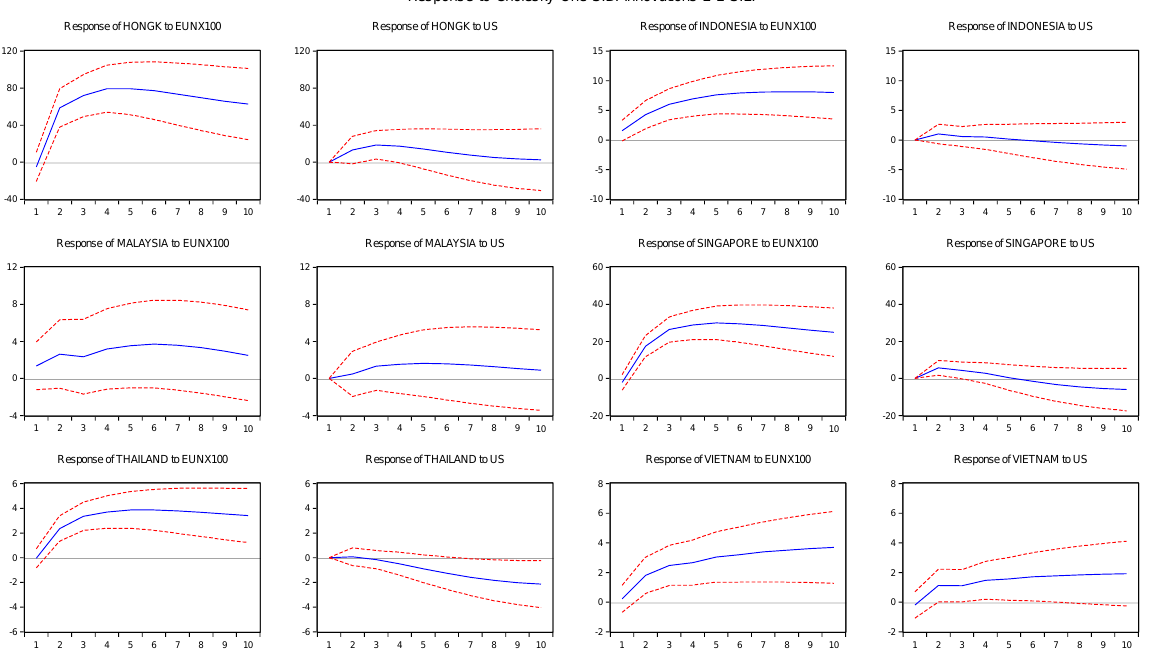
Figure 2. Response of Asian Stock Market to an Impulse in European and US Stock Markets During COVID-19